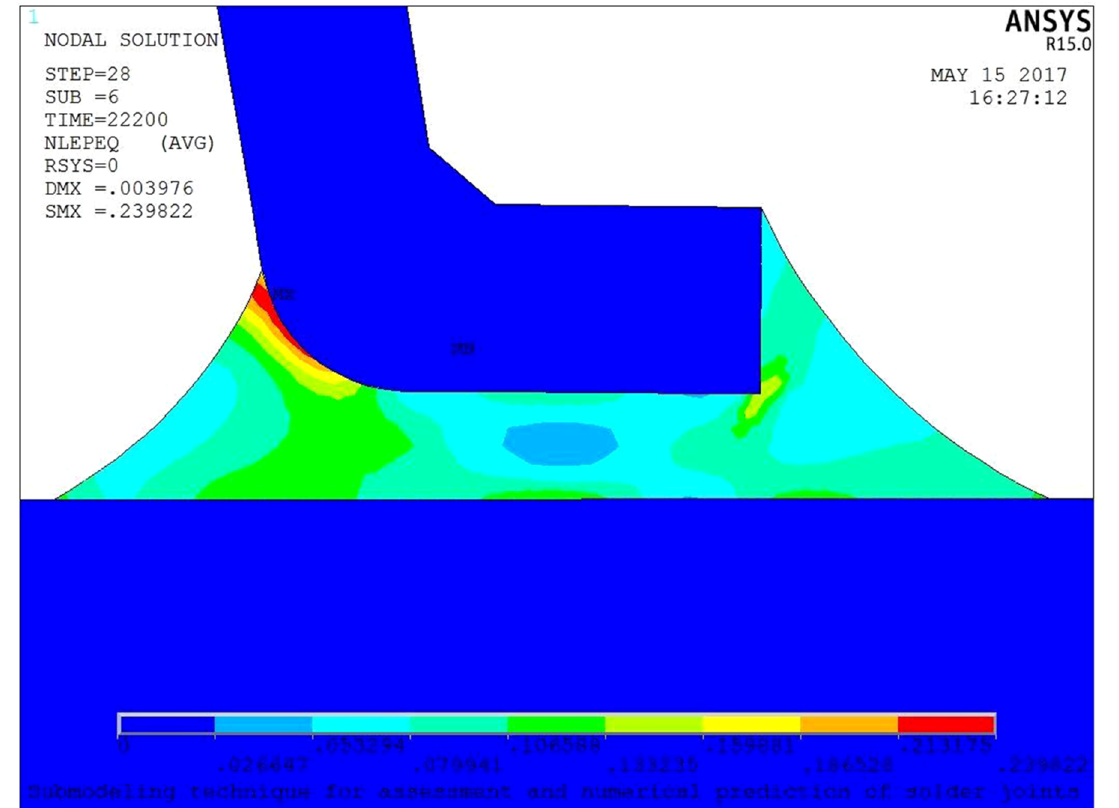
Fig. 7. Side view of plastic strain distribution in the solder joint at last loading thermal